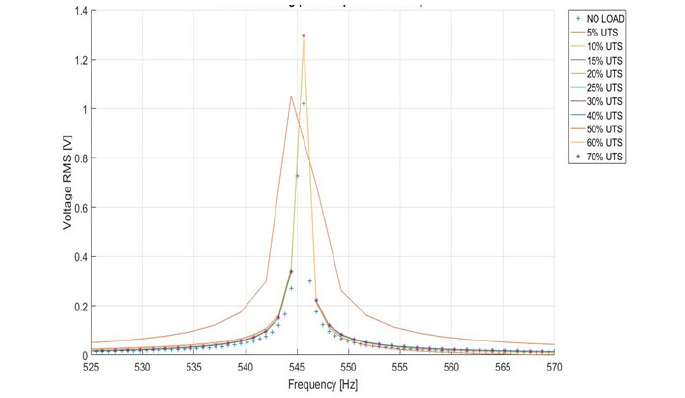
Figure 4. Voltage RMS as a function of frequency. A change in voltage RMS from 50% of the ultimate tensile strength (UTS) to 60% UTS indicated degradation of the